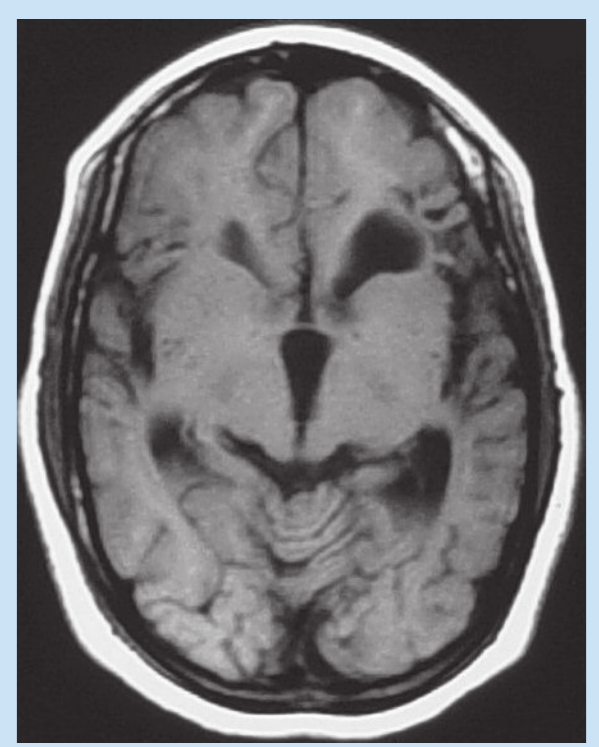
Fig. 2.3a. Axial postcontrast CT demonstrates the loss of the cortical rib- bon density at both the anterior and posterior watershed areas bilaterally, accompanied by localised swelling.